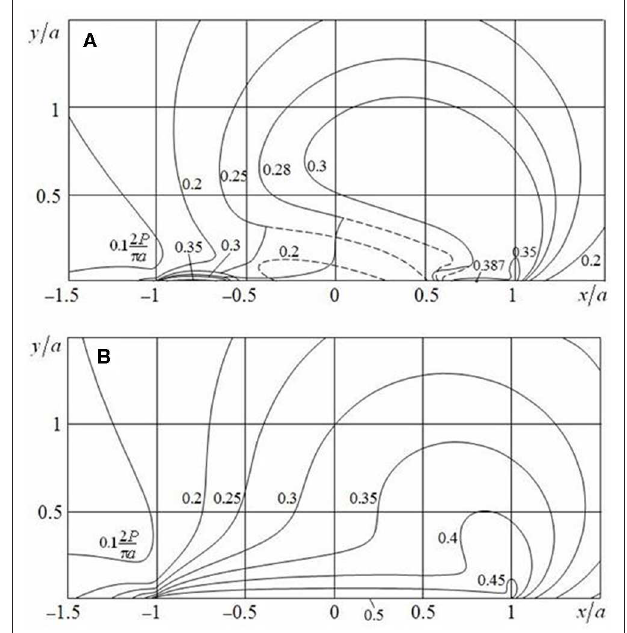
FIGURE 4 | Distribution of maximum tangential stress τ max in the cases of (A) contact with slip and adhesion ( µ 0 Q / P ( µ 0 0.5). = =